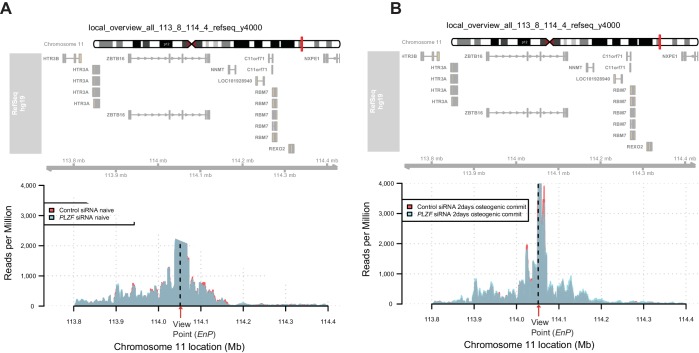
4C-sequencing map revealing that the PLZF knockdown (using siRNA) did not affect the contact frequency between the EnP element and NNMT promoter observed during early osteogenic differentiation (day 2).Plots show the overlap between control siRNA and PLZF siRNA in naive (A) or in early osteogenic induced hMSCs (day 2) (B).